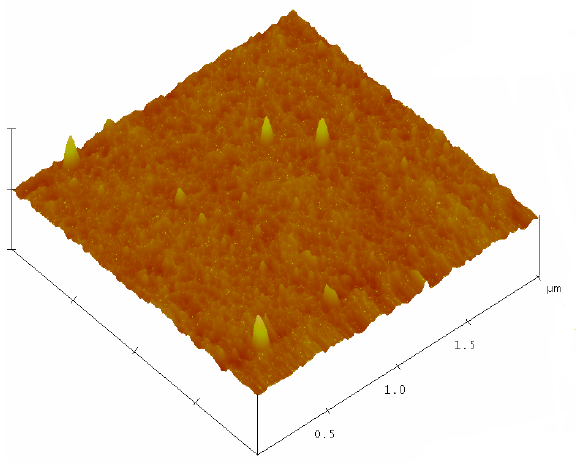
Figure 3. Morphology of kapton substrate by atomic force microscopy